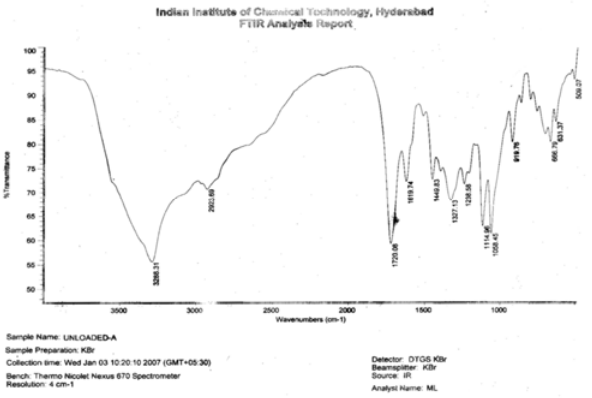
Figure13: FT-IR Spectra of FBM of Calotropis procera